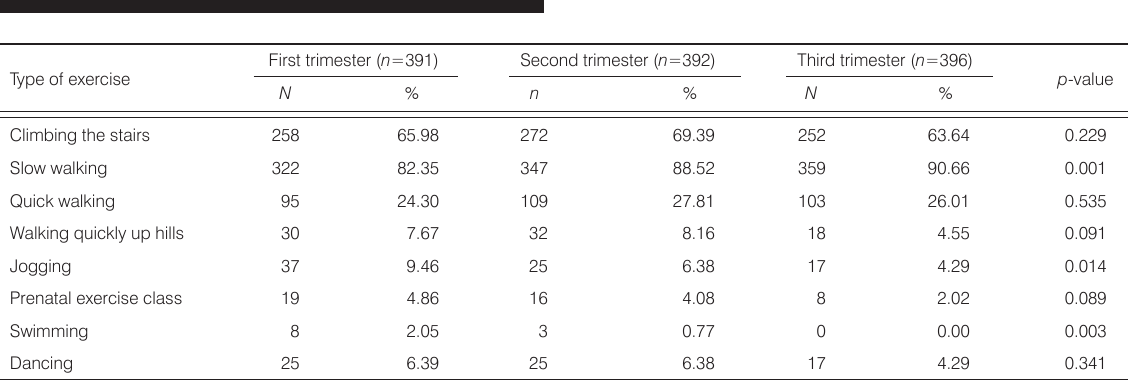
Table 5. Distribution of exercise type in different trimesters using the PPAQ among Chinese pregnant